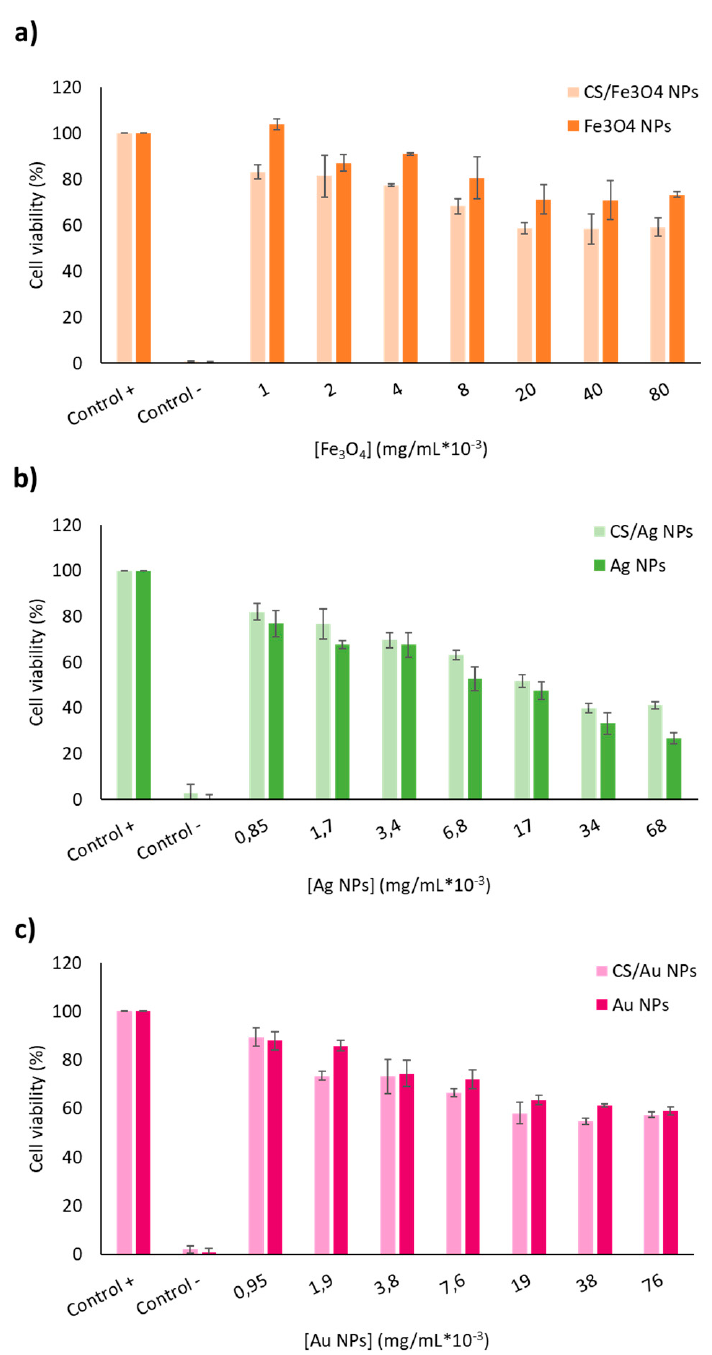
Figure 4. Cell viability assay of fibroblast as a function of different concentration of hybrid CS/metal nanoparticles versus free metal nanoparticles at the same concentration. ( a ) CS/Fe 3 O 4 NPs versus free Fe 3 O 4 NPs. ( b ) CS/Ag NPs versus free Ag NPs. ( c ) CS/Au NPs versus free Au NPs.